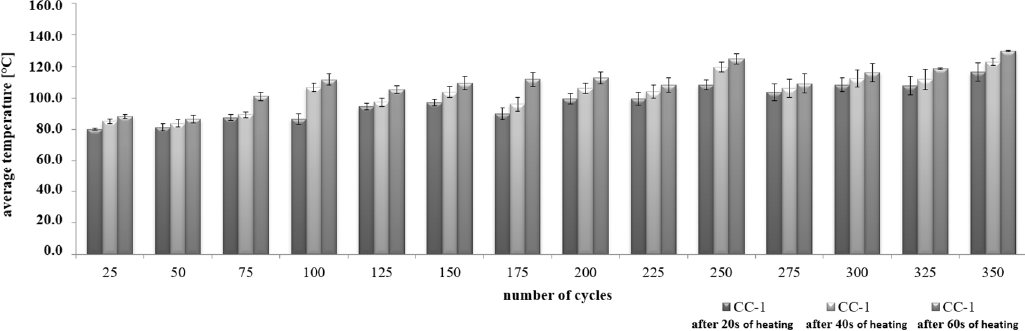
76.7 °C after 25 thermal cycles to 103.4 °C after 350 cycles. After 40 s of soaking, the mean values ranged from 84.4 °C to 111.3 °C after 350 cycles, respectively. On the other hand, after 60 s of heating, the mean temperature values ranged from 92.2 °C to 116.6 °C. Tem-